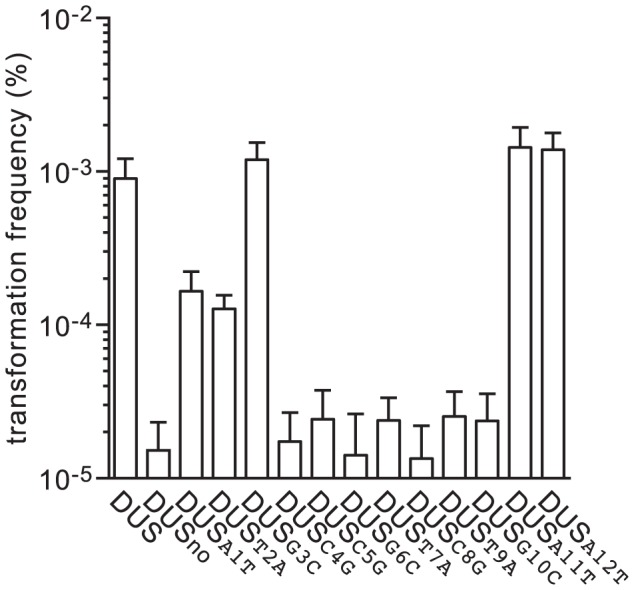
Seven inner bases of DUS are critical for enhancement of transformation.Competence for DNA transformation in N. meningitidis 8013 was quantified after transformation with 100 ng of ΔpilN PCR fragments containing a series of DUS mutants in which each base of the DUS was mutated. The specific transversion mutations are indicated in each case. As a control, the WT strain transformed with DUS and no DUS was included. Results are expressed as percentages of recipient cells transformed, and are the mean ± standard deviation of six independent experiments.